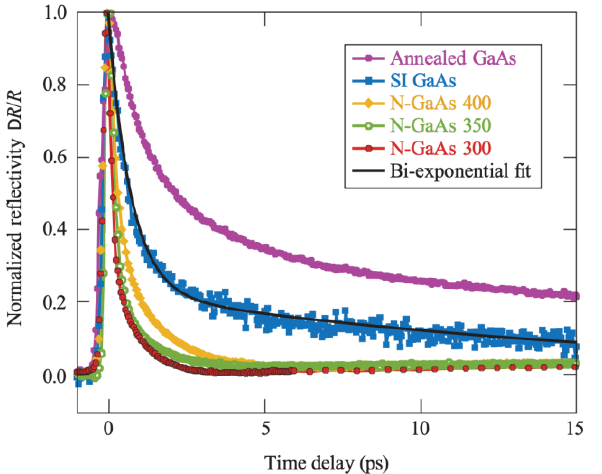
Figure 7. Normalized ∆ R / R waveforms of all five samples. The experimental data are shown as dots, and the bi-exponential fit is presented as a solid black line for a SI GaAs sample as an example. Each sample was tested on at least three different spots to eliminate any influence of sample inho- mogeneities.